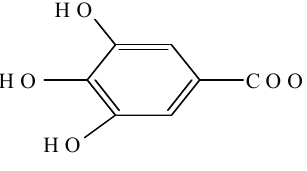
Figure 1. Molecular structure of gallic